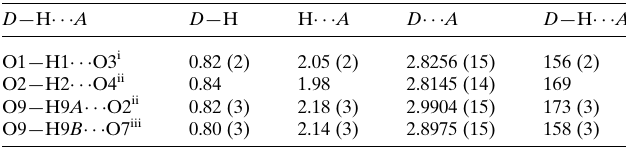
Table 2 Hydrogen-bond geometry (A˚ , (cid:5) ) for Na 2 (tiron) (cid:2) H 2 O. D —H (cid:2)(cid:2)(cid:2) A